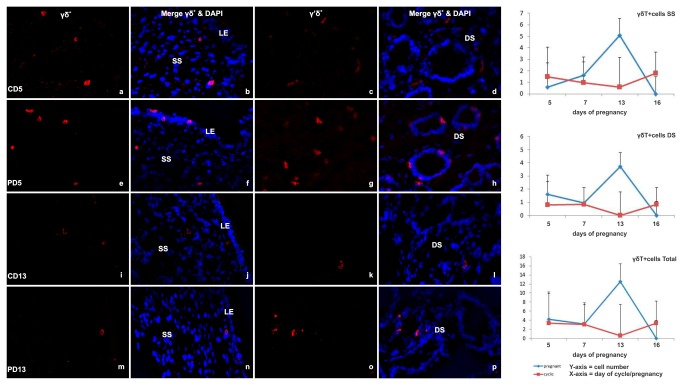
Immunofluorescent labeling of endometrial tissue for γδT-cells.(a-f) Representative images of immunofluorescent γδT cell receptor (WC1) labeling (green) in cells (nuclei labeled with DAPI [blue]) of the endometrial deep stroma (DS) from cyclic (C) Day 5 and pregnant (P) Day 7 and 16 -heifers (original magnification ×40). (g-i) Line graphs detailing the total number of γδT-cells in cyclic (red line) and pregnant (blue line) endometrial tissue based on the sum of immunofluorescent labeled cells per 2.25 mm2 field of view, in all areas (total γδT-cells+) and specifically in the SS and DS. Values plotted are least squared means and standard errors across 5 replicate animals per timepoint and per status.